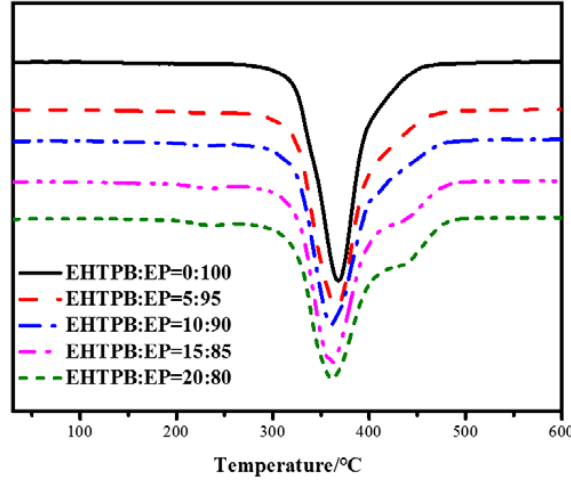
Figure 8. TG curves of the modified epoxy resin with different w(EHTPB)/w(EP) ratios.